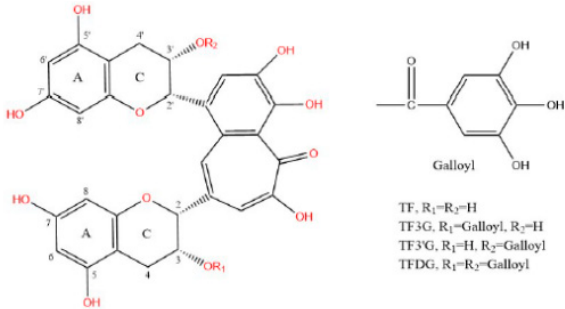
Figure 1. Structure of Theaflavins (TFs: TF, TF3G, TF3 (cid:48) G and TFDG). The small intestine is the main location of human digestion and the absorption of substances, and the human colon adenocarcinoma (Caco-2) cell model is a classic model for simulating the intestinal environment in vitro and studying the absorption and me- tabolism of substances [16]. Caco-2 cells can spontaneously undergo epithelioid di ff eren- tiation under in vitro culture conditions to form a monolayer of tightly connected cells with an intestinal lumen side (apical villus surface) and an intestinal wall side (basal sur- face), which possess the morphology and typical functions of the intestine. [17].